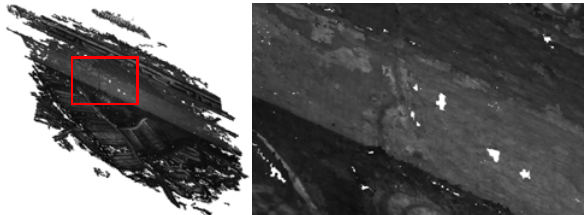
Figure 13. (left) Point cloud for the second location on the ceiling, tilted; (right) enlarged detail showing